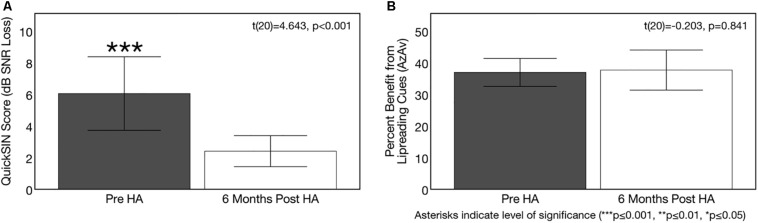
Effects of treatment with hearing aids on auditory speech perception in noise. Average scores on speech perception measures in the age-related hearing loss group pre-treatment (gray) and 6 months post-treatment with hearing aids (Post-HA) (white). Black bars indicate 95% confidence intervals for each group. Asterisks indicate level of significance (***p ≤ 0.001, **p ≤ 0.01, *p ≤ 0.05). (A) Depicts average binaural auditory speech perception in noise scores (QuickSINTM) before and after hearing aid treatment. Scores are plotted in terms of the dB signal-to-noise ratio loss (dB SNR), representing the dB SNR required for the participant to score 50% of words in a sentence correct relative to normal hearing listeners. A higher score indicates poorer auditory speech perception in noise performance. The dotted line indicates the cutoff score (3 dB SNR) for normal function in background noise. The hearing loss group exhibited significant improvements in auditory speech perception in noise after treatment with hearing aids. (B) Shows average benefit from visual (lip-reading) cues on a binaural auditory-visual speech perception in noise test (AzAv). Scores indicate the percent difference score in an auditory-only condition relative to an auditory-visual condition, where a higher score indicates greater benefit from the addition of visual (lip-reading) cues. No significant difference in lip-reading benefit was observed between pre-post intervention test sessions in the hearing loss group.